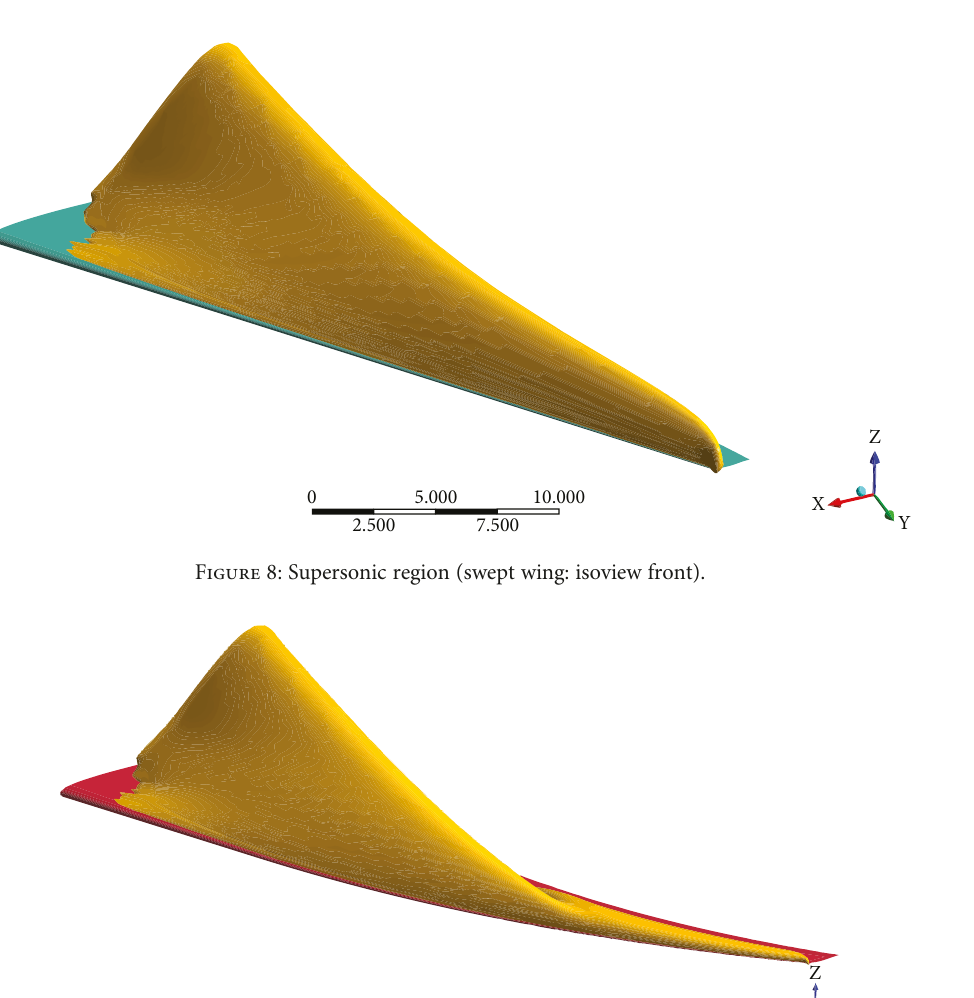
M = 0 85 ; top image: curved wing, bottom image: swept wing). L = 0 4 ,